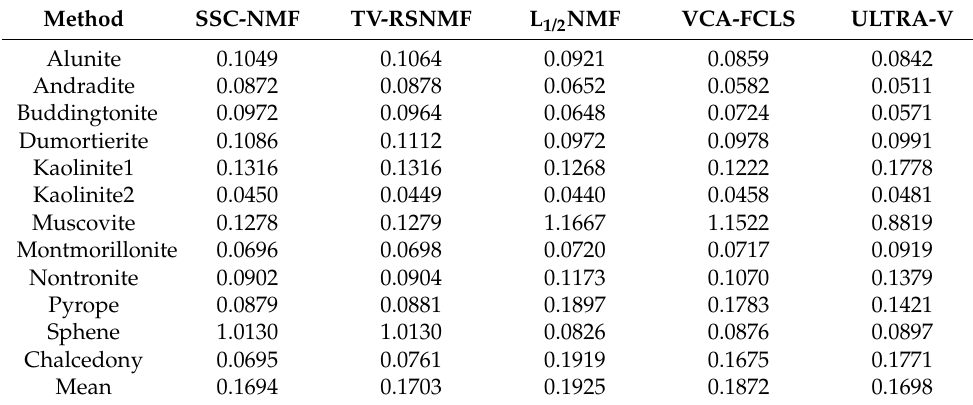
Table 4. SAD values of different methods with the real Cuprite dataset.